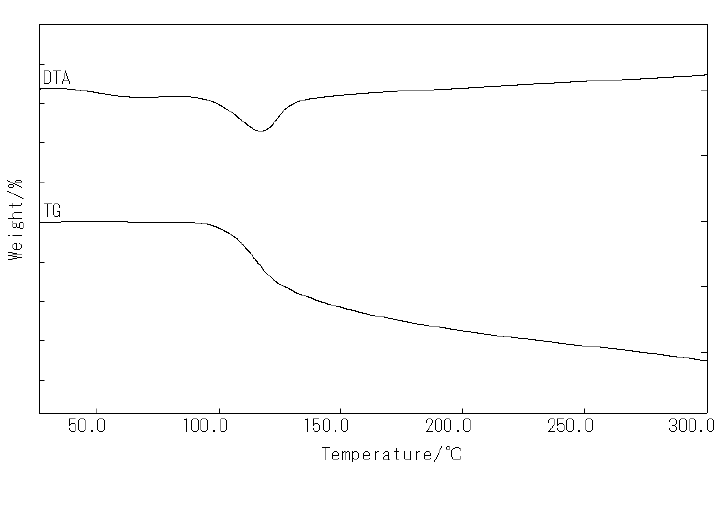
Figure 2. TG trace of ( R )-MOF- 2